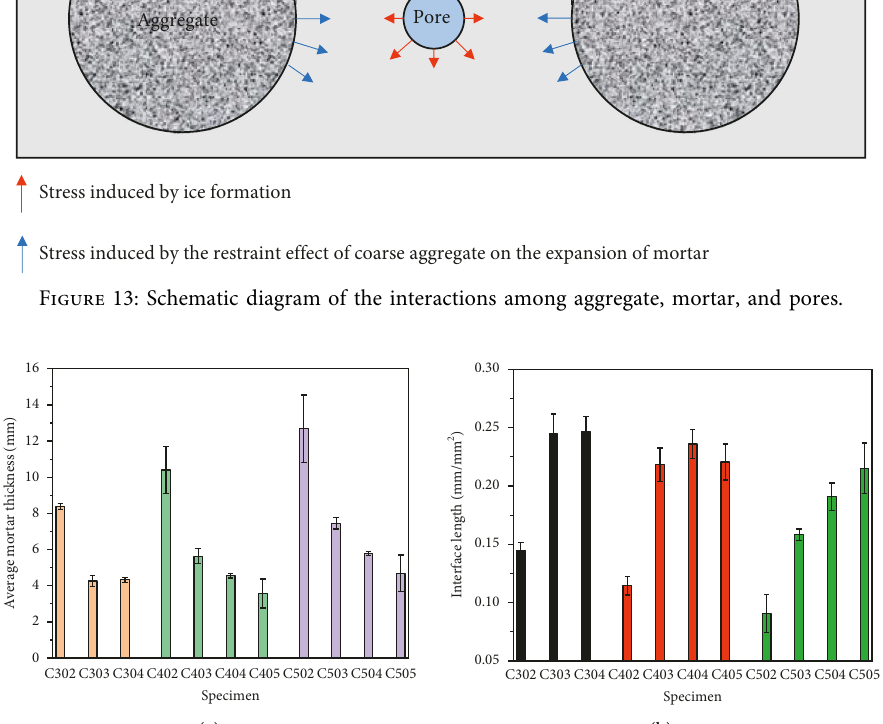
Figure 14: Variation of mortar thickness and interface length with aggregate